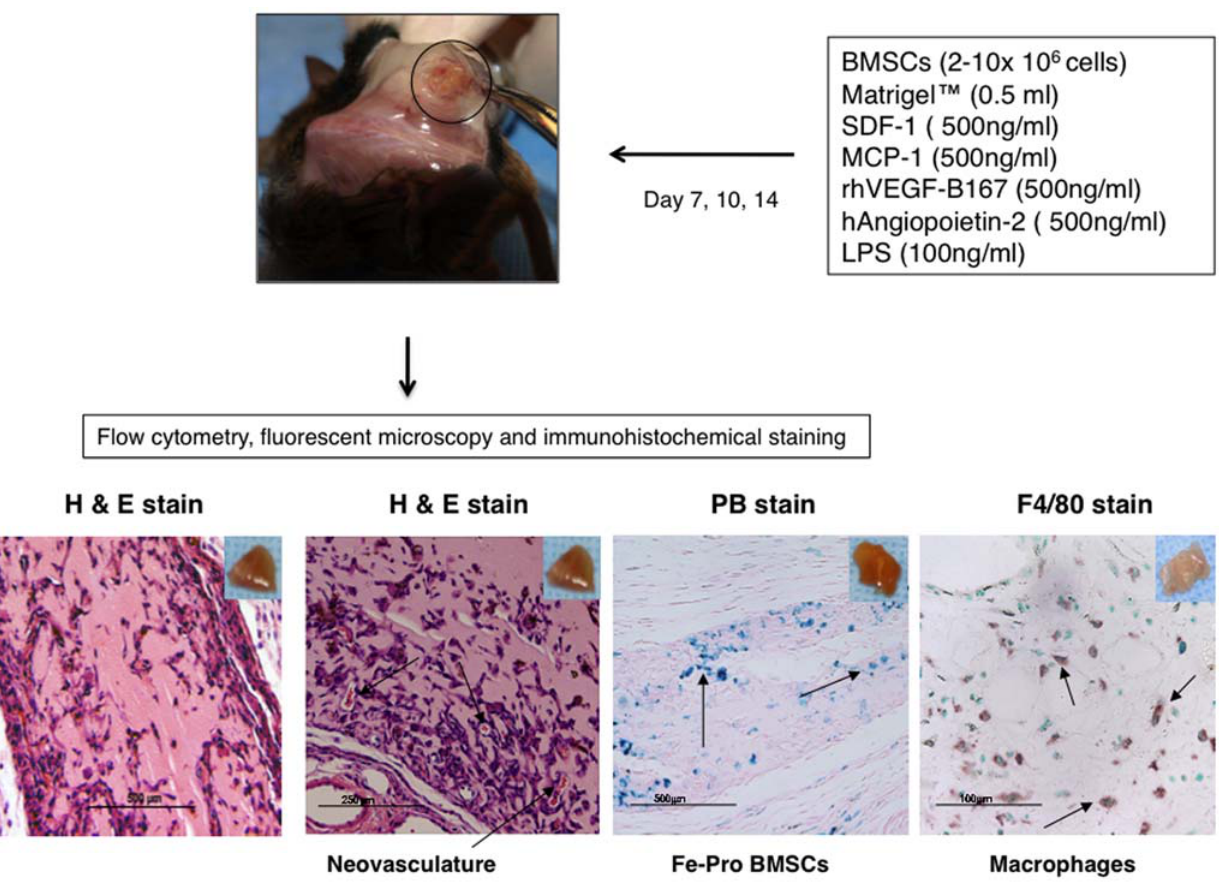
Figure 2. Schema of modified Matrigel TM plaque perfusion assay. Matrigel TM plaques (MPs) containing labeled bone marrow stromal cells (BMSCs), growth factors, chemokines and inflammatory molecules, are implanted into both flanks of 6-week-old 129/SvlmJ mice, and harvested at various time points for flow cytometry and microscopy analysis. Note representative images of collected MPs and immunohistochemical stains revealing neovasculature on H & E staining, iron-labeled cells on Prussian blue (PB) staining or the presence of F4/80 positive macrophages (brown cells), magnification 20X.